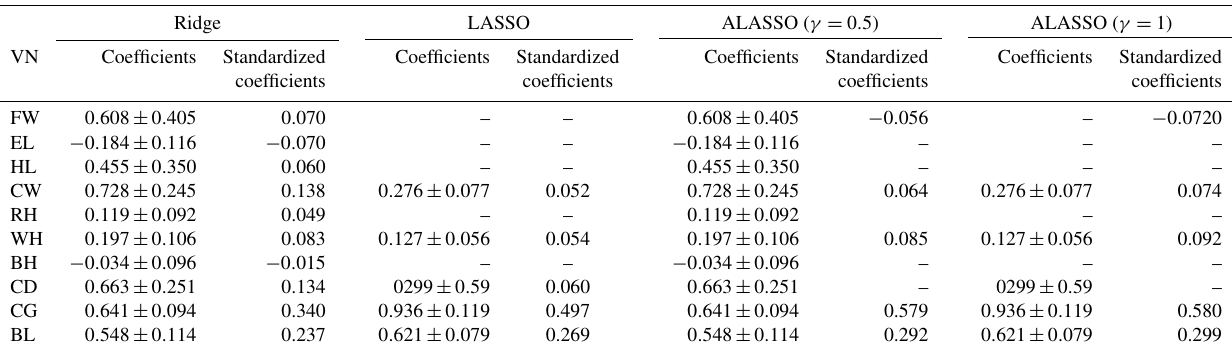
Table 4. Coefficients and standardized coefficients of Ridge, LASSO, and ALASSO ( γ = 0 . 5 and γ = 1) in multiple linear regression for female goats.